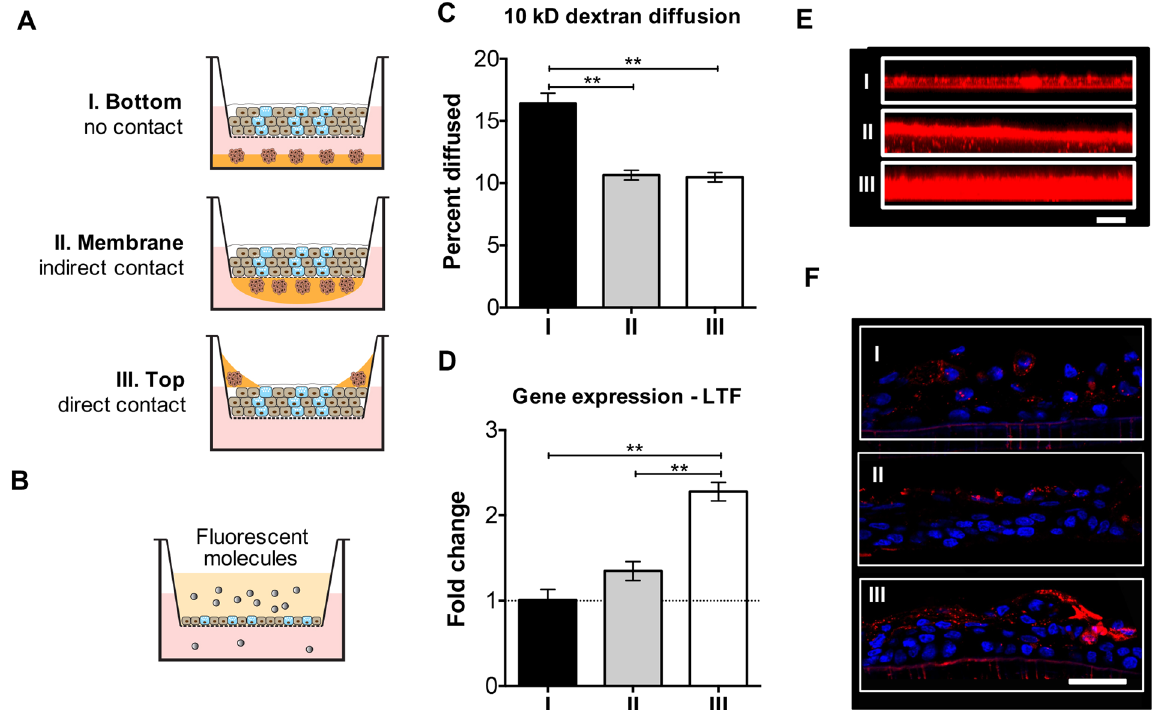
Figure 5. Comparison of different coculture model systems. ( A ) The three different designs of coculture system, which were named after the relative interactions between CECs and LG cell spheroids. ( B , C ) Diffusion study (with fluorescent 10 kD dextran). Data in ( C ) was presented as percent of dextran diffused through. ( D ) LTF gene expression across the three coculture designs. ( E ) Secreted mucin layer from airlifted CECs in coculture, visualized by confocal microscopes (z scan). Scale bar 100 μ m. ( F ) MUC5AC IHC staining (red fluorescence; nuclei were counterstained with DAPI) of the airlifted CECs. Scale bar 50 μ m. * p < 0.05; ** p <